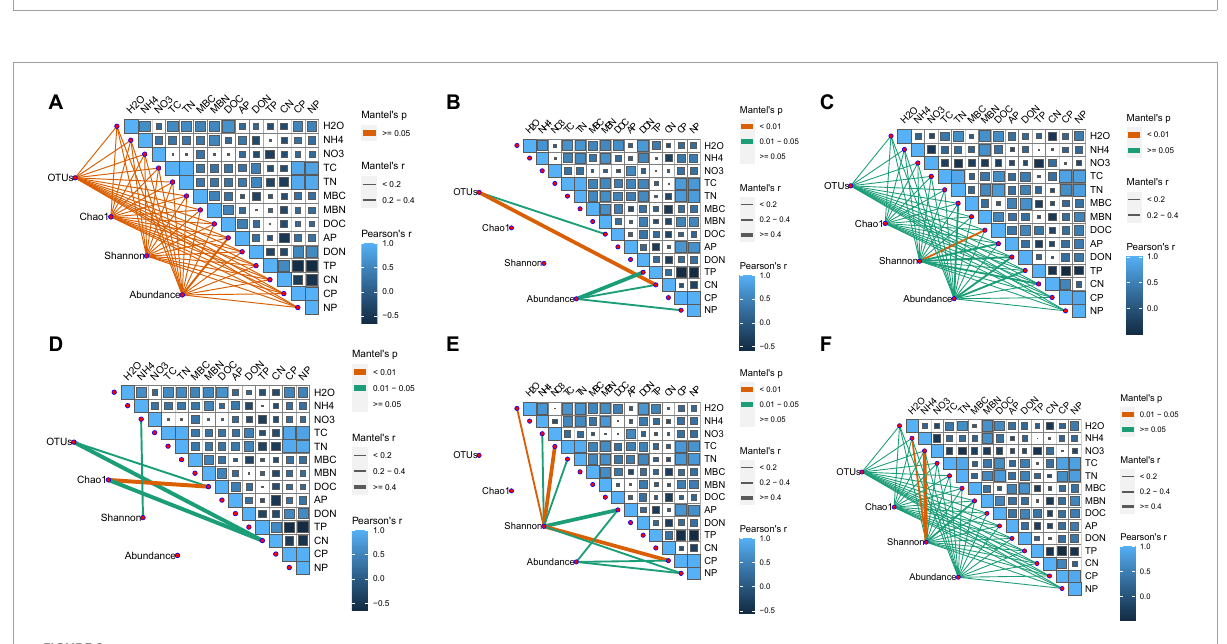
FIGURE2 Correlations among soil chemical parameters and bacterial (A–C) and fugal (D–F) diversity indexes (OTUs, Chao1, Shannon, and gene abundance) in different soil layers, 0–10 cm (A,D) , 10–20 cm (B,E) , and 20–40 cm (C,F) . The correlation coefficients of each soil chemical parameter are presented by area size of squares, smaller area lower correlation, and vice versa. The level of correlations between microbial index and soil chemical variables is indicated by line thickness; the correlations are indicated by the line color; red and blue colors indicate positive and negative correlation,